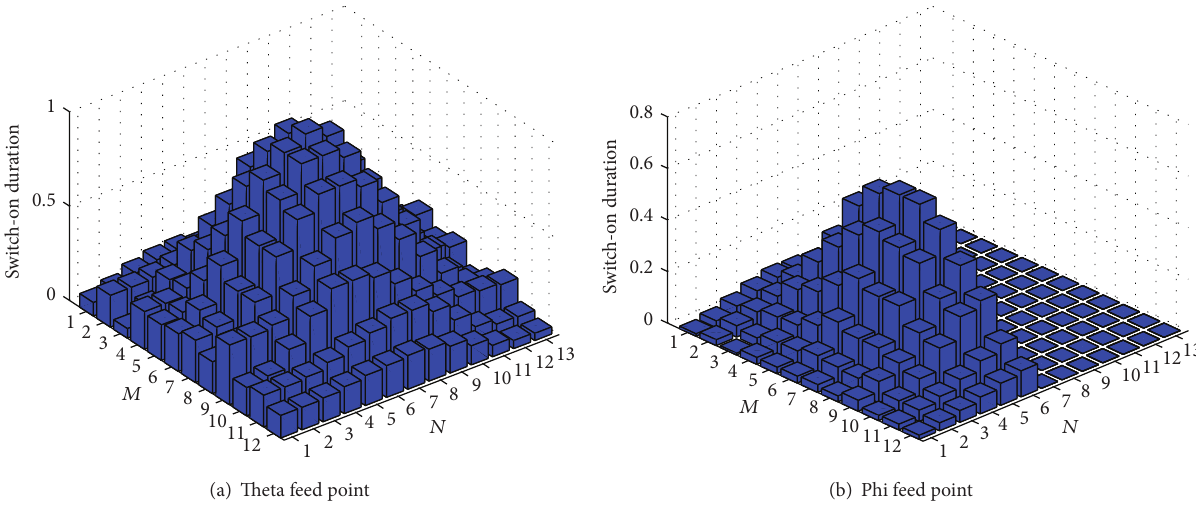
Figure 17: Optimized switch-on durations in the theta feed point and phi feed point for scan direction of (105 ∘ ,0 ∘ ) for solution A in Figure 7.